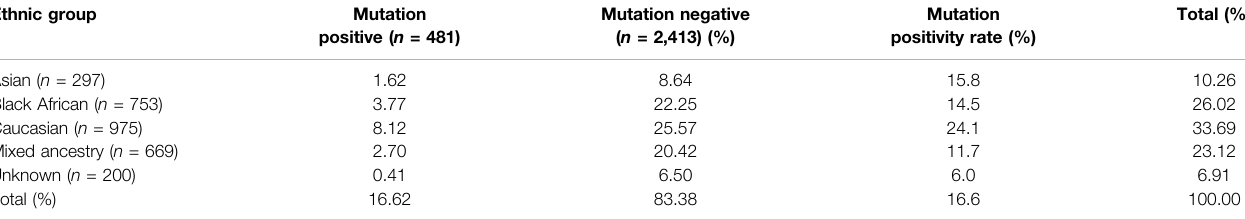
TABLE 3 | Illustration of the mutation detection and positivity rate per major population group (re fl ected in percentages) observed for the major groups. Ethnic group